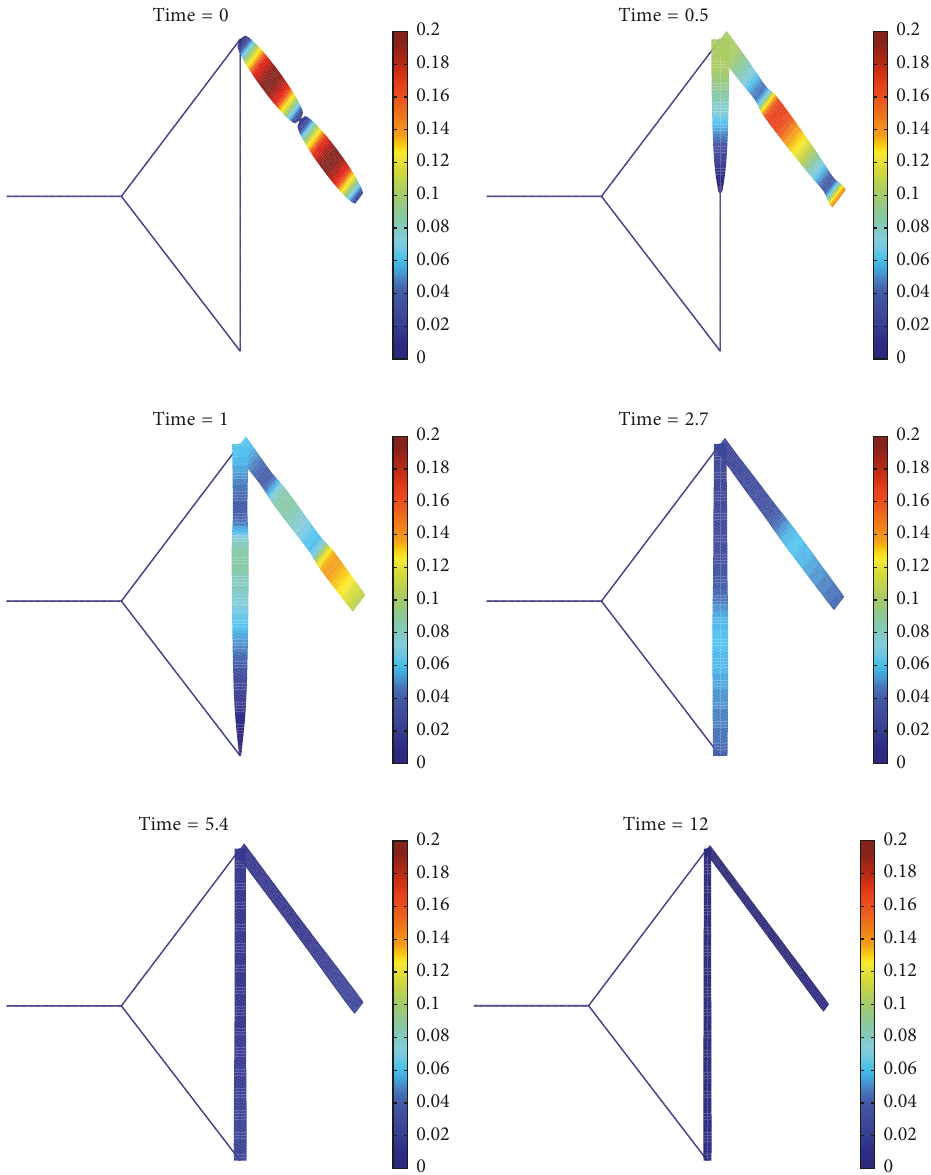
Figure 5: Evolution of the perturbation with Δ𝑥 = 0.01